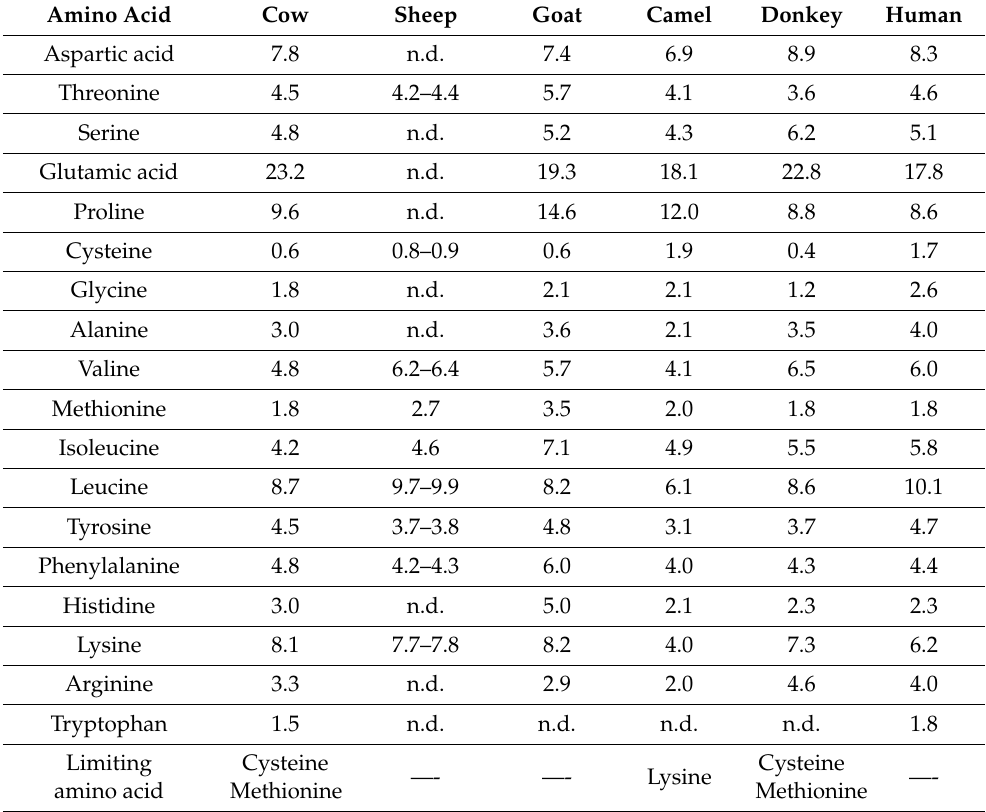
Table 3. Amino acid concentrations (g/100 g protein) in milk from different mammalian